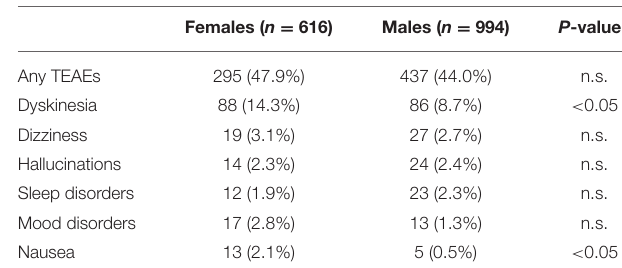
TABLE 6 | Summary of treatment emergent adverse events (TEAEs) according to